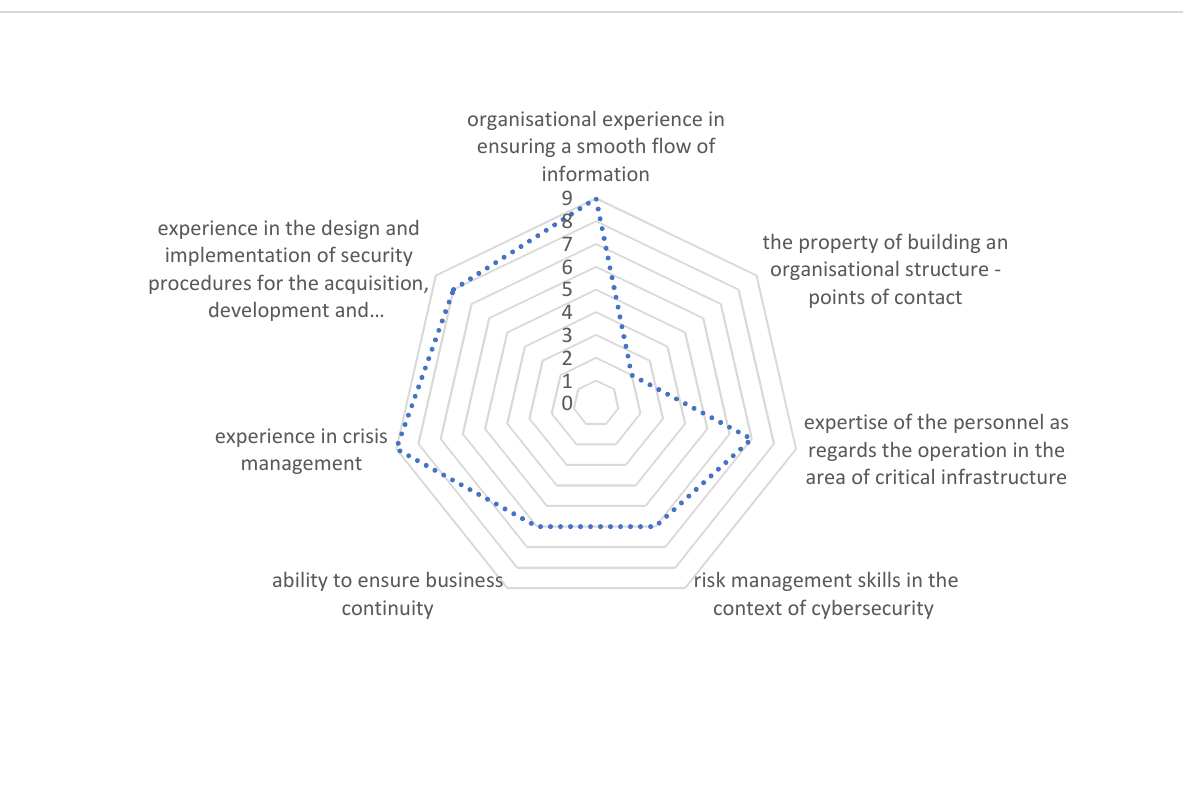
Figure 3. Assessment of the capability of the designated postal operator to provide an adequate level of security for the transmission of information within the energy infrastructure. Source: Authors’ own